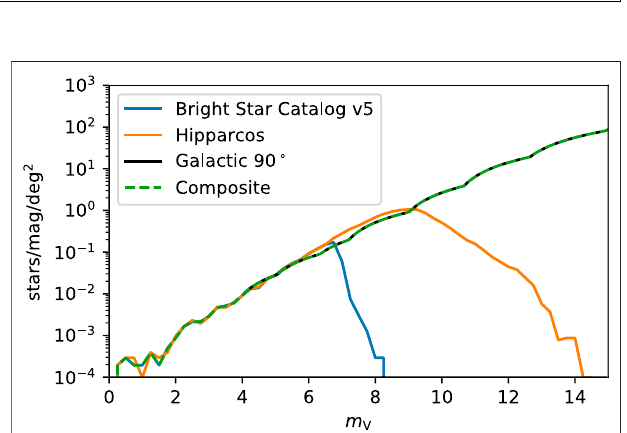
FIGURE 3 | Control system block diagram.